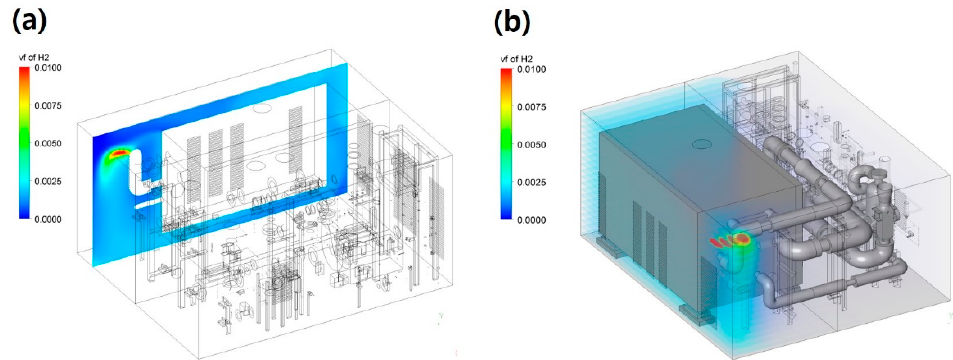
Figure 6. ( a ) One vertical section and ( b ) horizontal sections of the volume fraction of leaked hydrogen inside the MCFC stack package.